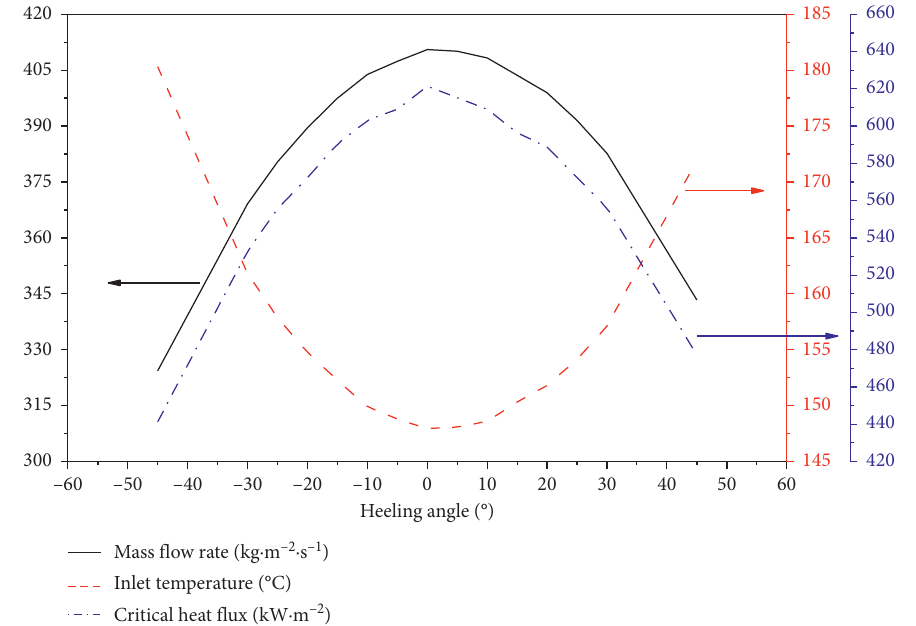
Figure 11: Influence of heeling angle on CHF.